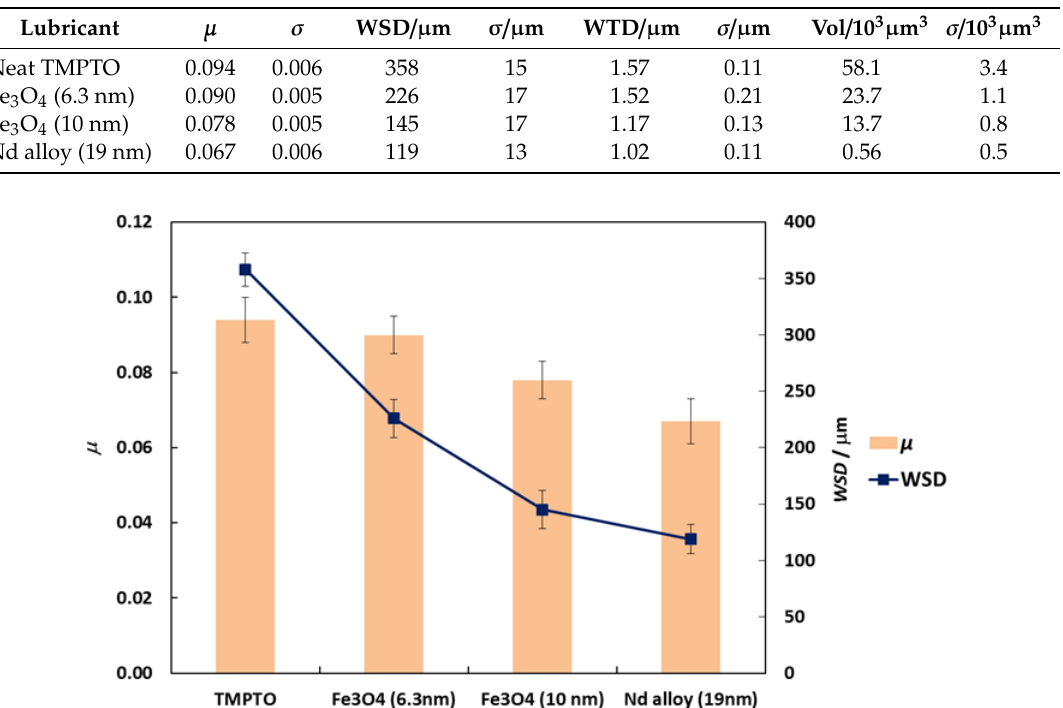
Figure 8. Evolution of friction coe ffi cient values for TMTPO base oil and nanolubricants of TMPTO and 0.015 wt% of each NP with the sliding distance at 20 ◦ C. Table 4. Mean values of friction coe ffi cient ( µ ) and of the diameter (wear scar diameter, WSD), depth (wear track depth, WTD) and volume of the wear hole and their respective standard deviations ( σ ) for all nanolubricants for the TMPTO base oil and the three nanolubricants with 0.015 wt% of each NP.